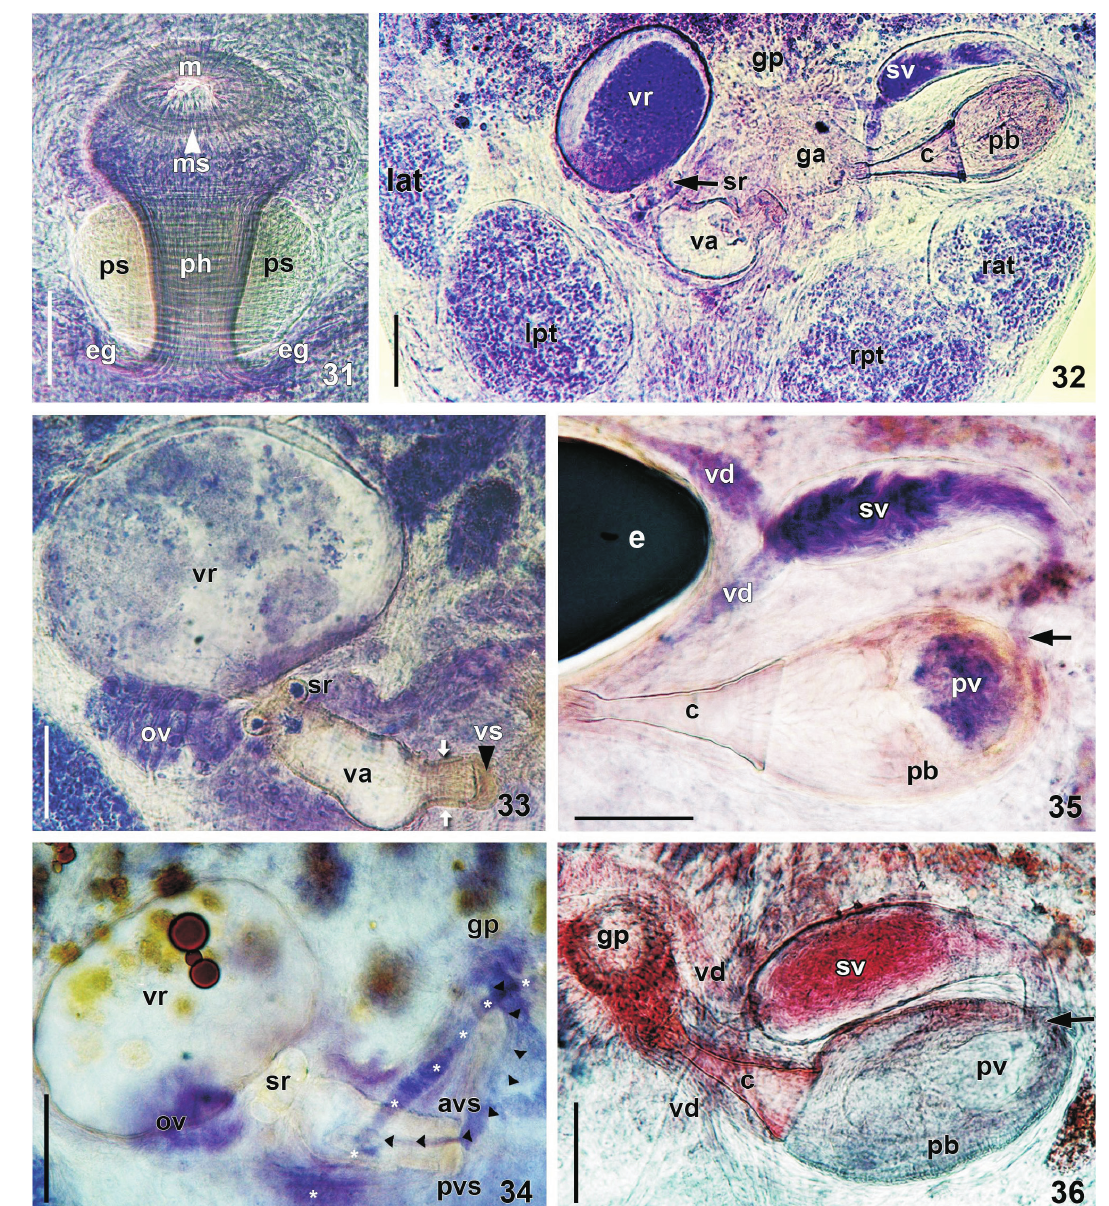
Figures 31-36. Temnocephala iheringi , selected characters in the internal anatomy: (31) mouth (m), mouth sphincter (ms), pharynx (ph), pharyngeal sphincter (ps), esophageal glands (eg), bar = 100 µm; (32) reproductive zone: left anterior testis (lat), left posterior testis (lpt), right posterior testis (rpt), right anterior testis (rat), genital pore (gp), genital atrium (ga), cirrus (c), prostatic bulb (pb), seminal vesicle (sv), vagina (va), seminal receptacles (sr), vesicula resorbens (vr), bar = 100 µm; (33-34) partial female reproductive complex (33) vesicula resorbens (vr), ovary (ov), seminal receptacles (sr), vagina (va), distal vagina with muscular wall (arrows), vaginal sphincter (vs) (head arrow), bar = 100 µm; (34) different focusing plane: vesicula resorbens (vr), ovary (ov), seminal receptacles (sr), anterior (avs) and posterior (pvs) portions of the circular vaginal sphincter, genital pore (gp), vasa deferentia (stars), trajectory of spermatozoids toward the vagina (head arrows), bar = 250 µm; (35-36) partial male reproductive complex, bar = 100 µm: (35) vasa deferentia (vd), seminal vesicle (sv), prostatic bulb (pb), prostatic vesicle with spermatozoids (pv), cirrus (c), egg (e); (36) specimen stained with aceto-carmine/fast-green: genital pore (gp), vasa deferentia (vd), seminal vesicle (sv) and its insertion point (arrow) with the prostatic bulb (pb), prostatic vesicle (pv), cirrus